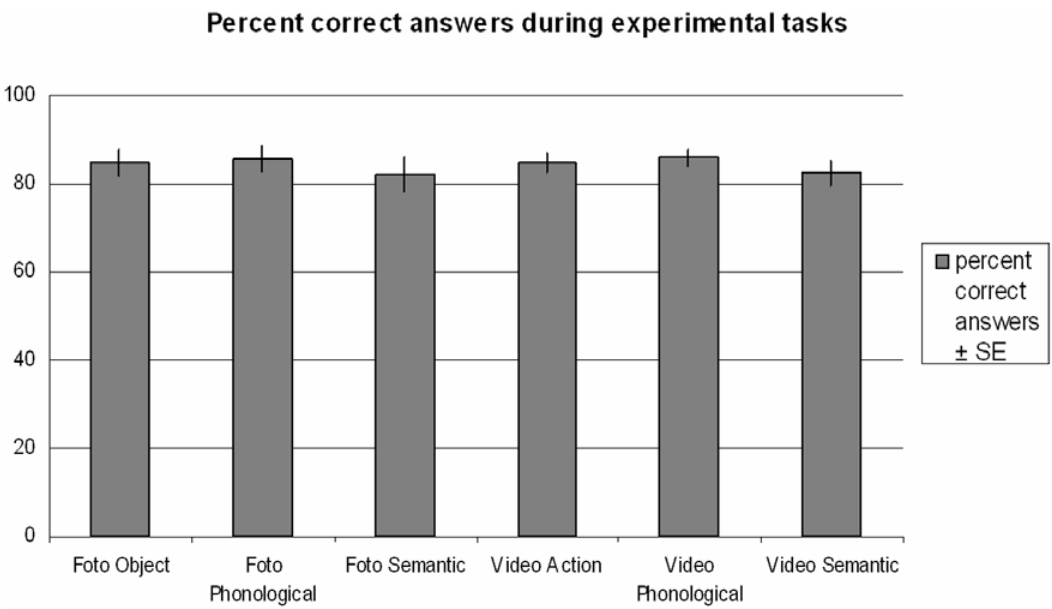
Figure 2. Behavioral data of correctness for all experimental tasks. There were no differences regarding correctness across tasks. However, the tasks involving video stimuli (Vd-Perc, Vd-Conc, Vd-Phon) regarded longer reaction times than the photo stimulus tasks with the video action task evoking the longest reaction times. This reflects the nature of this task, focusing attention towards the performed hand action, whereas the other tasks directed attention towards the depicted object.